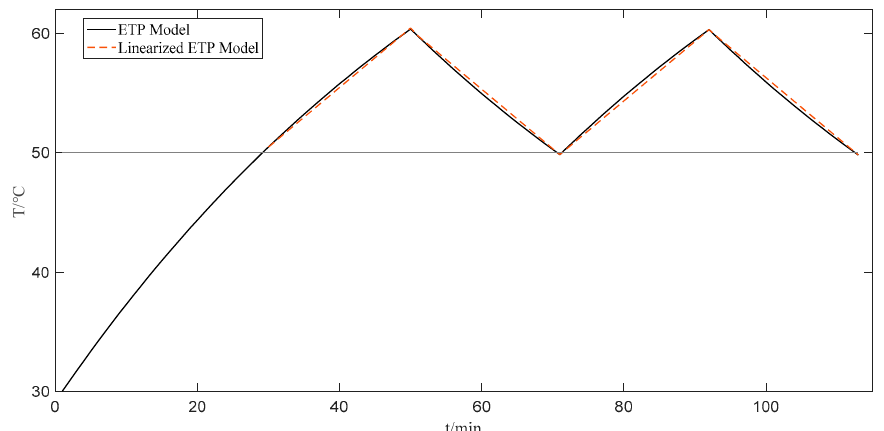
Figure 6. Comparison of temperature curves between linearized model and original ETP model.